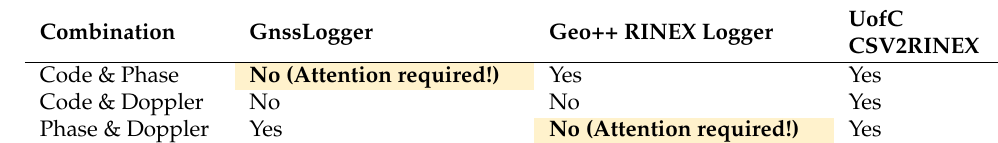
Table 4. Consistency between different GNSS observations in three RINEX files.